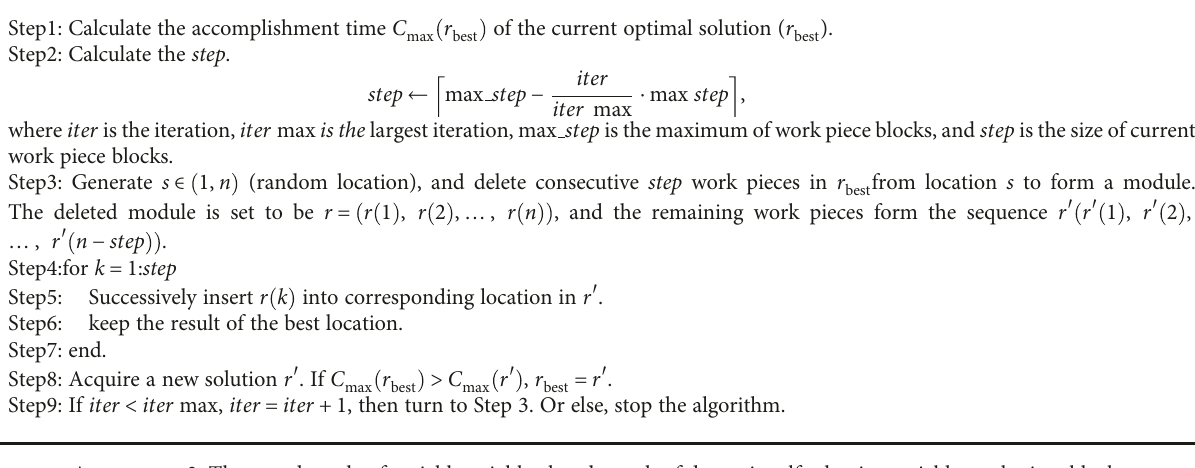
Algorithm 2: The pseudo code of variable neighborhood search of dynamic self-adaptive variable work piece